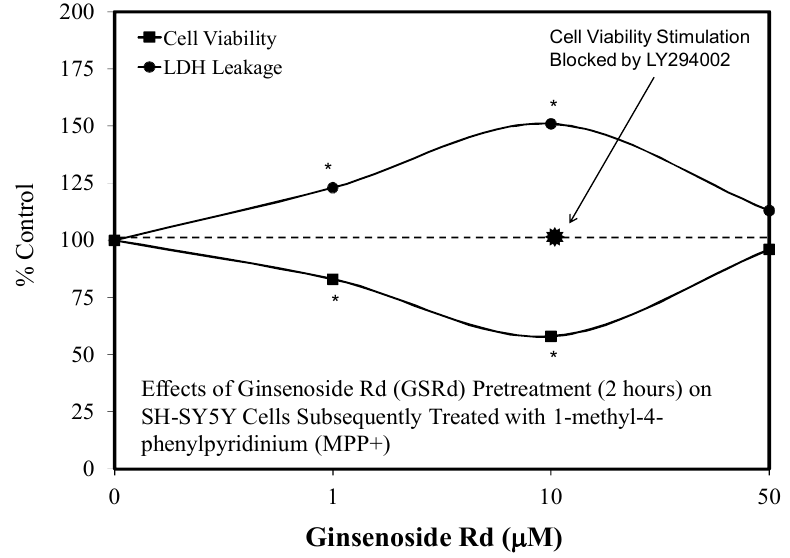
Figure 27. Effects of ginsenoside Rd (GSRd) pretreatment (2 h) on SH-SY5Y cells subsequently treated with 1-methyl-4-phenylpyridinium (MPP+) (source: [105]). Each * represent statistical significance for a data point.